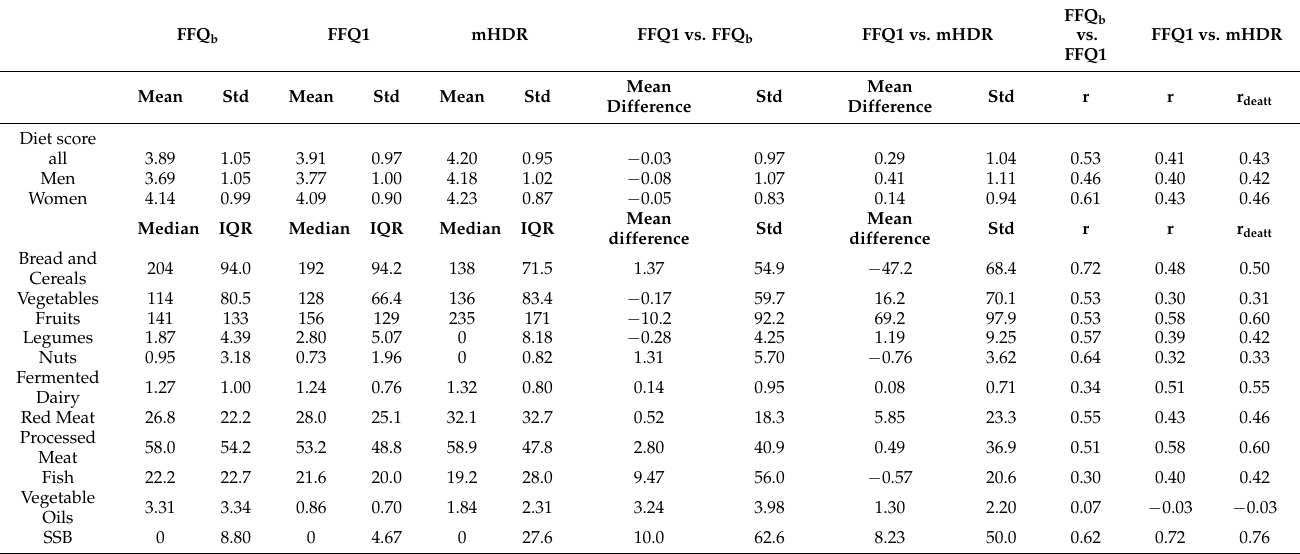
Table 4. Reliability and relative validity of the new diet score and its components.